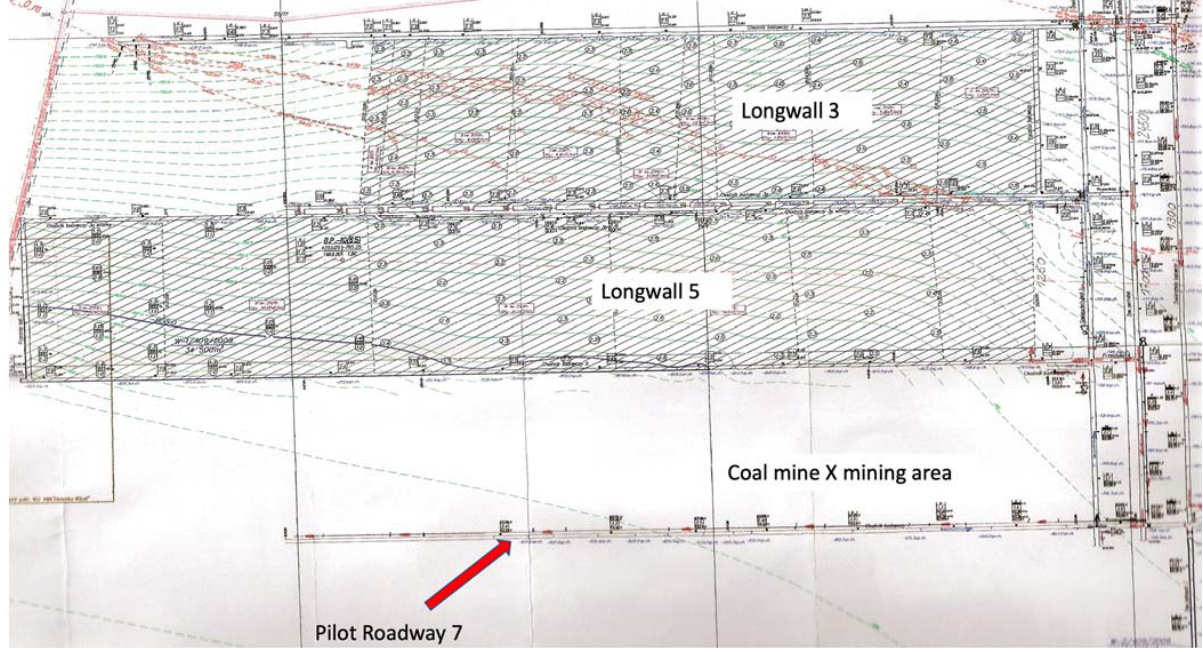
Figure 1. The map of the seam 409 with marking the analyzed Pilot Roadway 7.